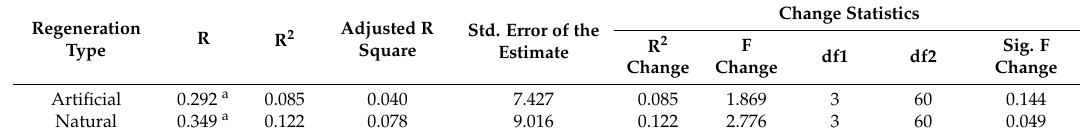
Table 4. Model summary, which describes the relation between the two different regeneration methods as dependent variables and potential solar radiation parameters as independent variables derived from the UAV. Std. Error of the Estimate Sig. F